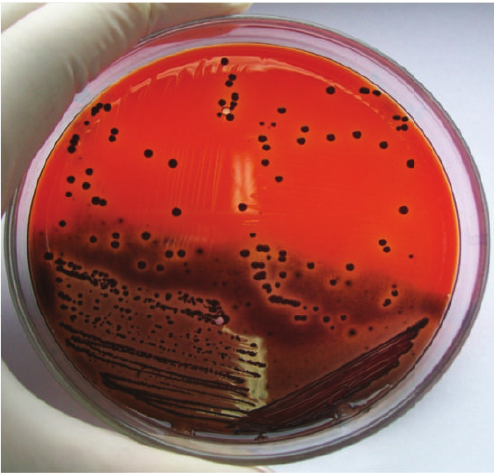
Figure 2: PCR detection of ica A and ica D genes. Lane 1: